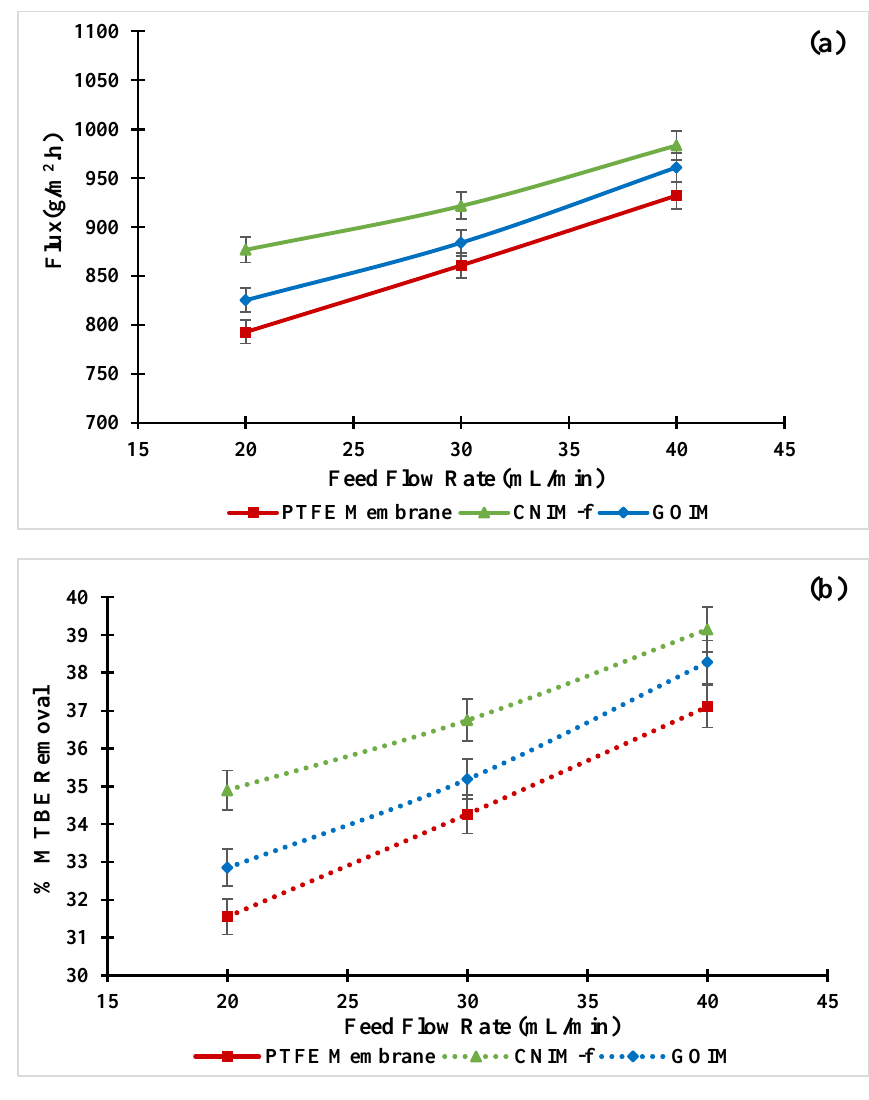
Figure 7. ( a ) Effect of feed flow rate on MTBE flux, and ( b ) % MTBE removal as the function of feed flow rate at the feed concentration of 1.5 wt% and the feed temperature of 30 °C.